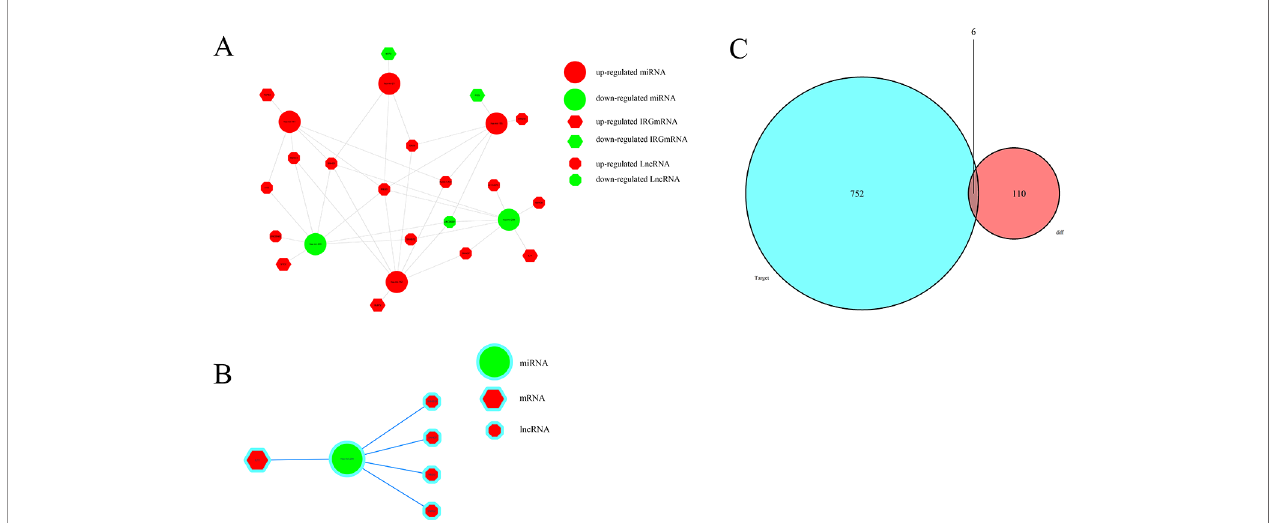
FIGURE 7 | The ceRNA network of mRNA, miRNA, and lncRNA: (A) Relationship between survival-associated IRG mRNA, miRNA, and lncRNA. (B) IL-11/miRNA- 204/LncRNA axis. (C) Venn diagram of DEmiRNA target mRNA and DEIRGmRNAs.